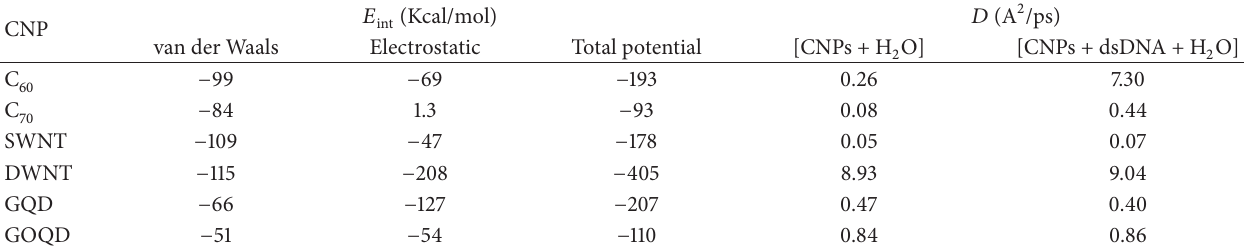
Table 2: Interaction energies ( 𝐸 int ) of the dsDNA fragment on the surface of the carbon nanoparticles (CNPs). 𝐸 int CNP